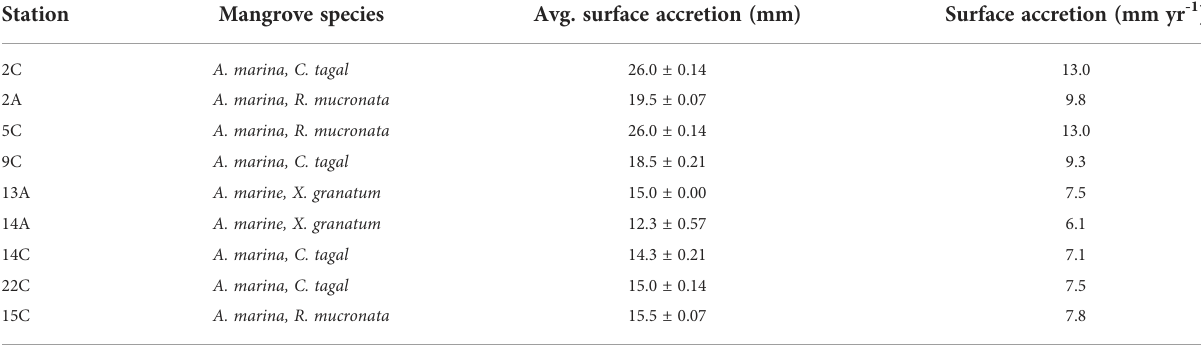
TABLE 1 Measured rates of surface accretion in the mangroves of Vanga, Kenya, for two years. Station